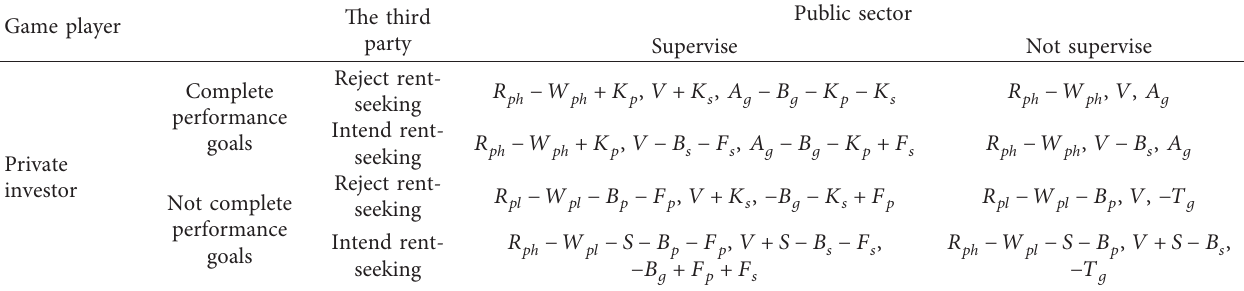
Table 1: Evolutionary game matrix between the private investor, third party, and public